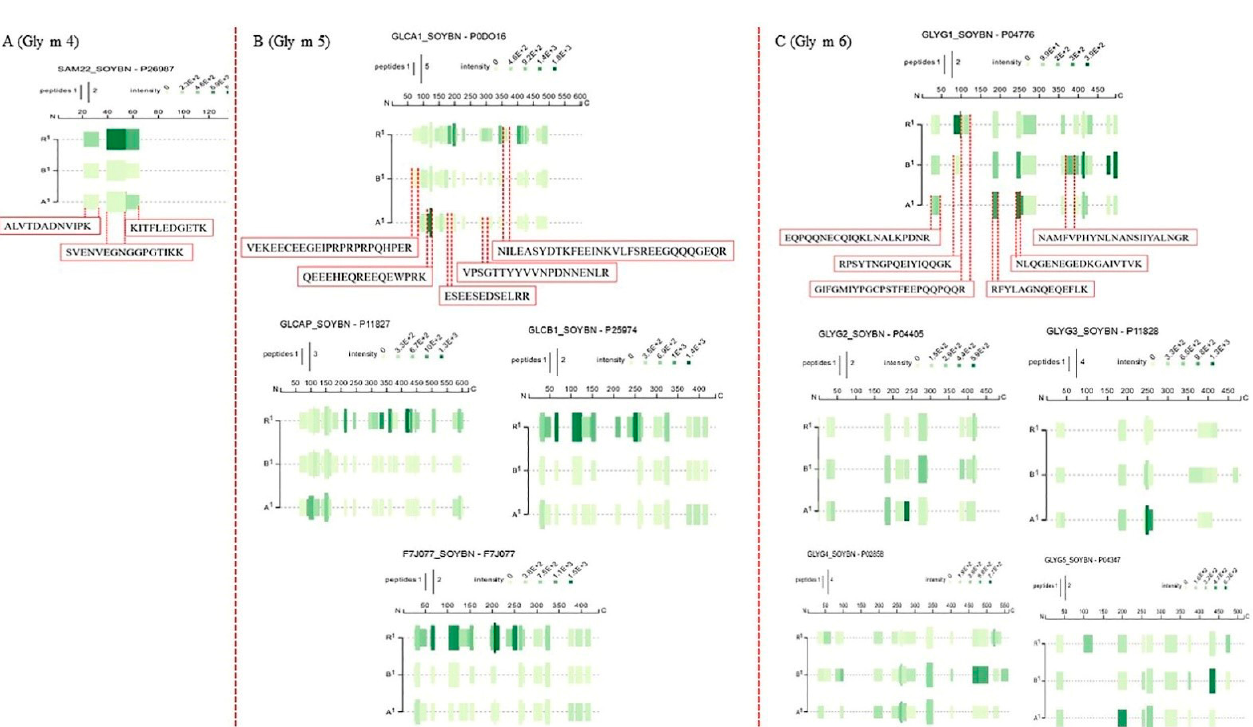
Table S1 Information of patients allergic to soybeans; Table S2: The molecular weight of soybean allergens (Amnuaycheewa & de Mejia, 2010; Pi, Sun, Fu, et al., 2021); Table S3: The information of proteins; Table S4: Changes in epitopes in Gly m 4 and Gly m 5 among extracted proteins from raw, boiled and autoclaved soybeans.